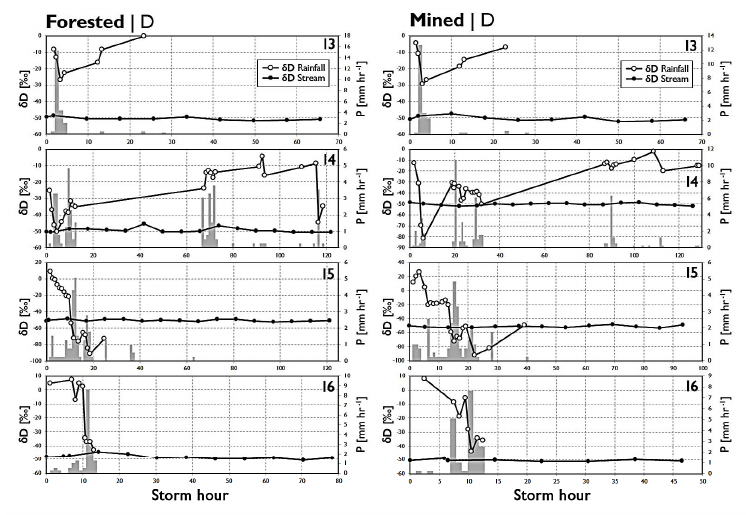
Figure 9. Plots of δ D of rainfall and stream for selected events (13–16) for the mined and forested catchments. δ 18 O showed similar patterns for the same events. Rainfall in mm h − 1 shown in gray. Despite variations in rainfall isotopic compositions throughout storm events that in come cases crossed over, the stream isotopic composition showed little response to rainfall input, making hydrograph separation impossible for all but one